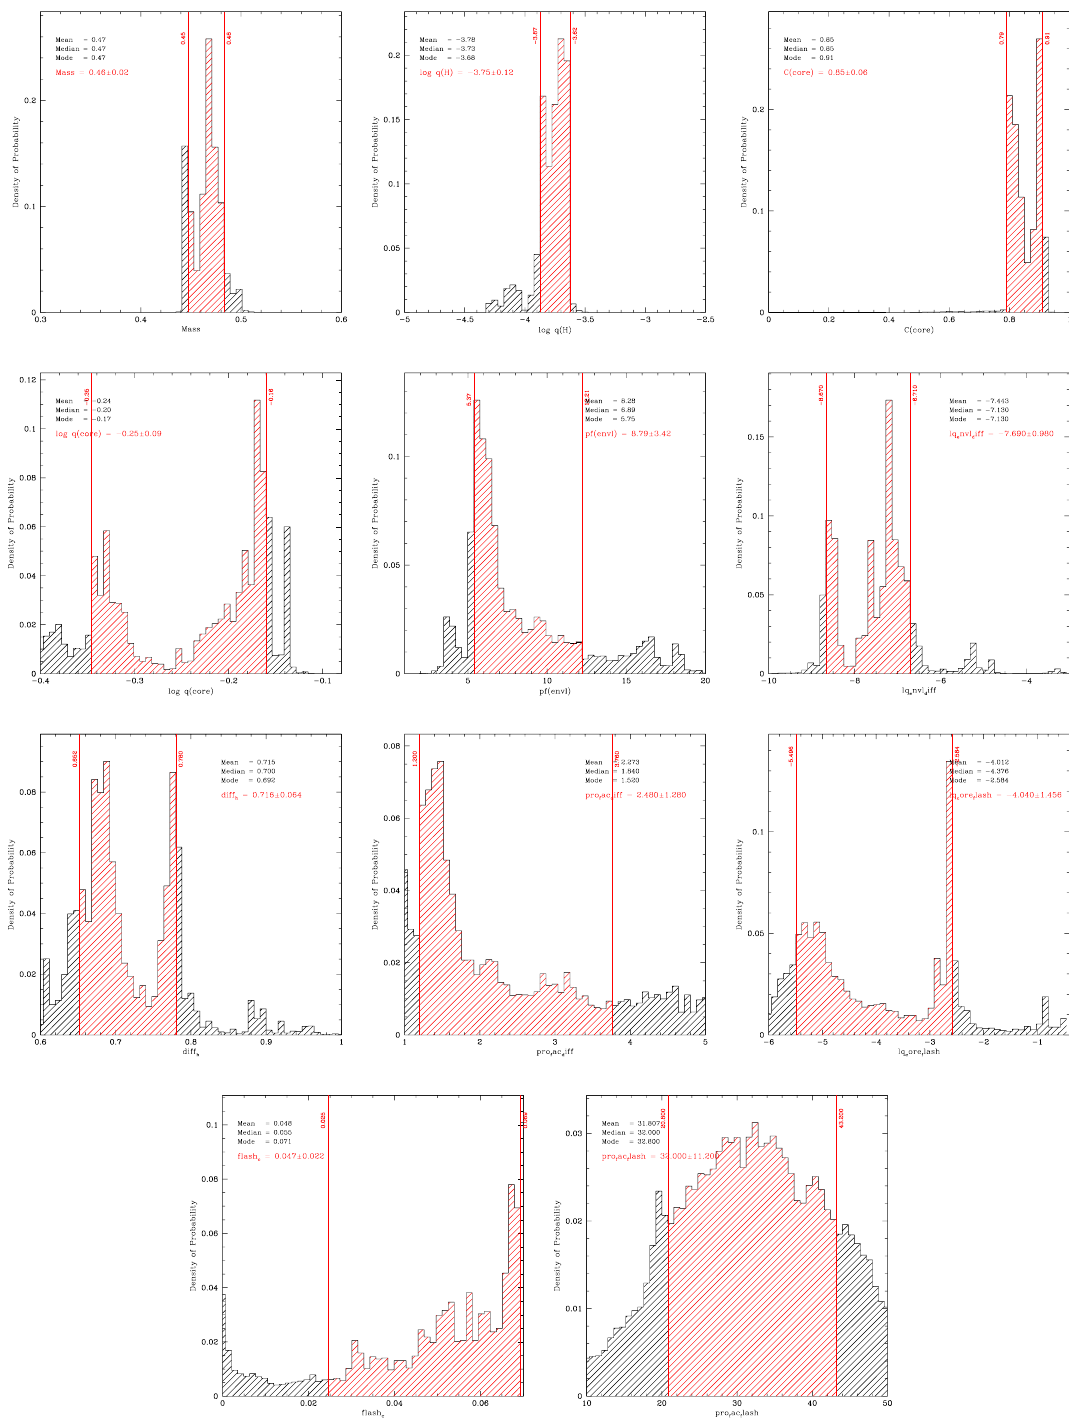
Figure 7. Probability density functions derived from asteroseismology for various parameters of the 4G models. The red-hatched regions between the two vertical solid red lines shows the 1 σ range containing 68.3% of the